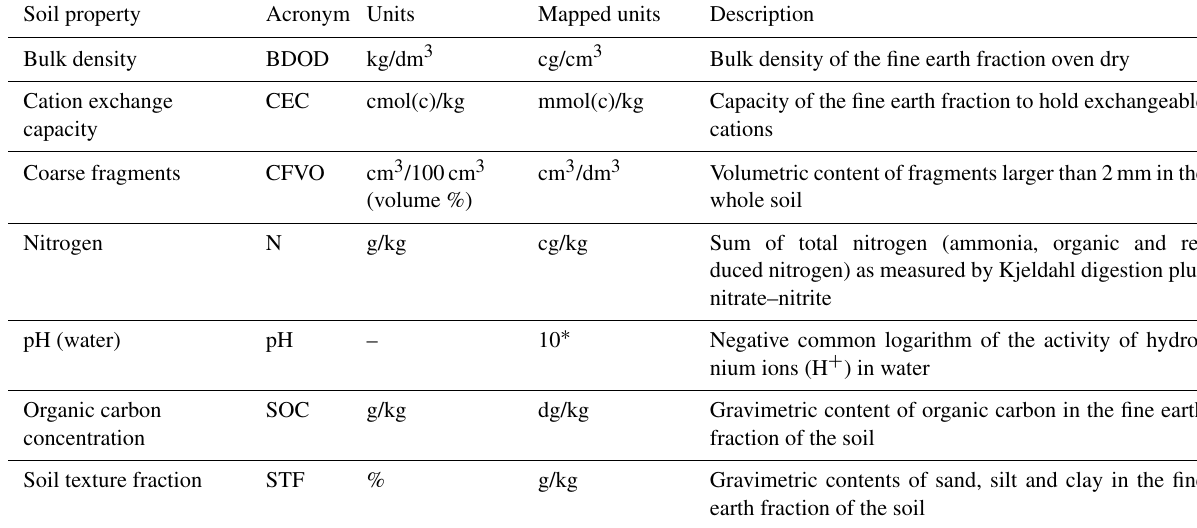
Figure 1. Workflow of the methodological approach. Table 1. Soil properties description and